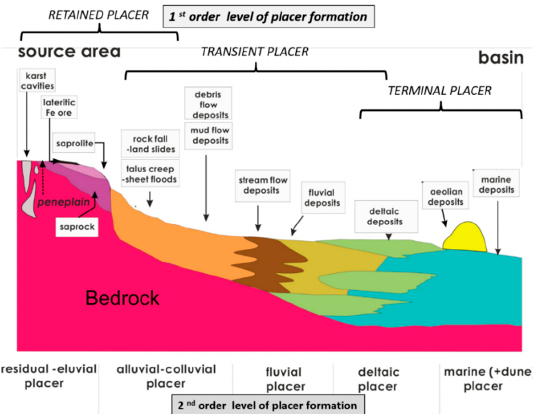
Figure 1. Cartoon to show the different types of placer deposits from the source area to the basin, from the weathering mantle on the top of the exposed bedrock through the continental terrigenous lithofacies types into the marine lithofacies. Glacial and fluvial-glacial lithofacies types because of the minor relevance for placer deposits in terms of separating light and heavy minerals are not shown in the cartoon.